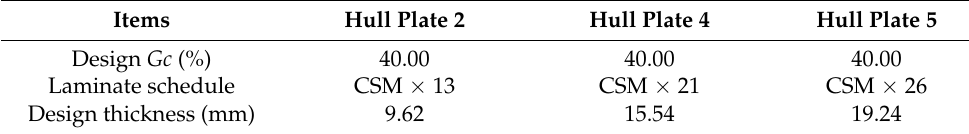
Table 2. Design details of the thickness variation group specimens.